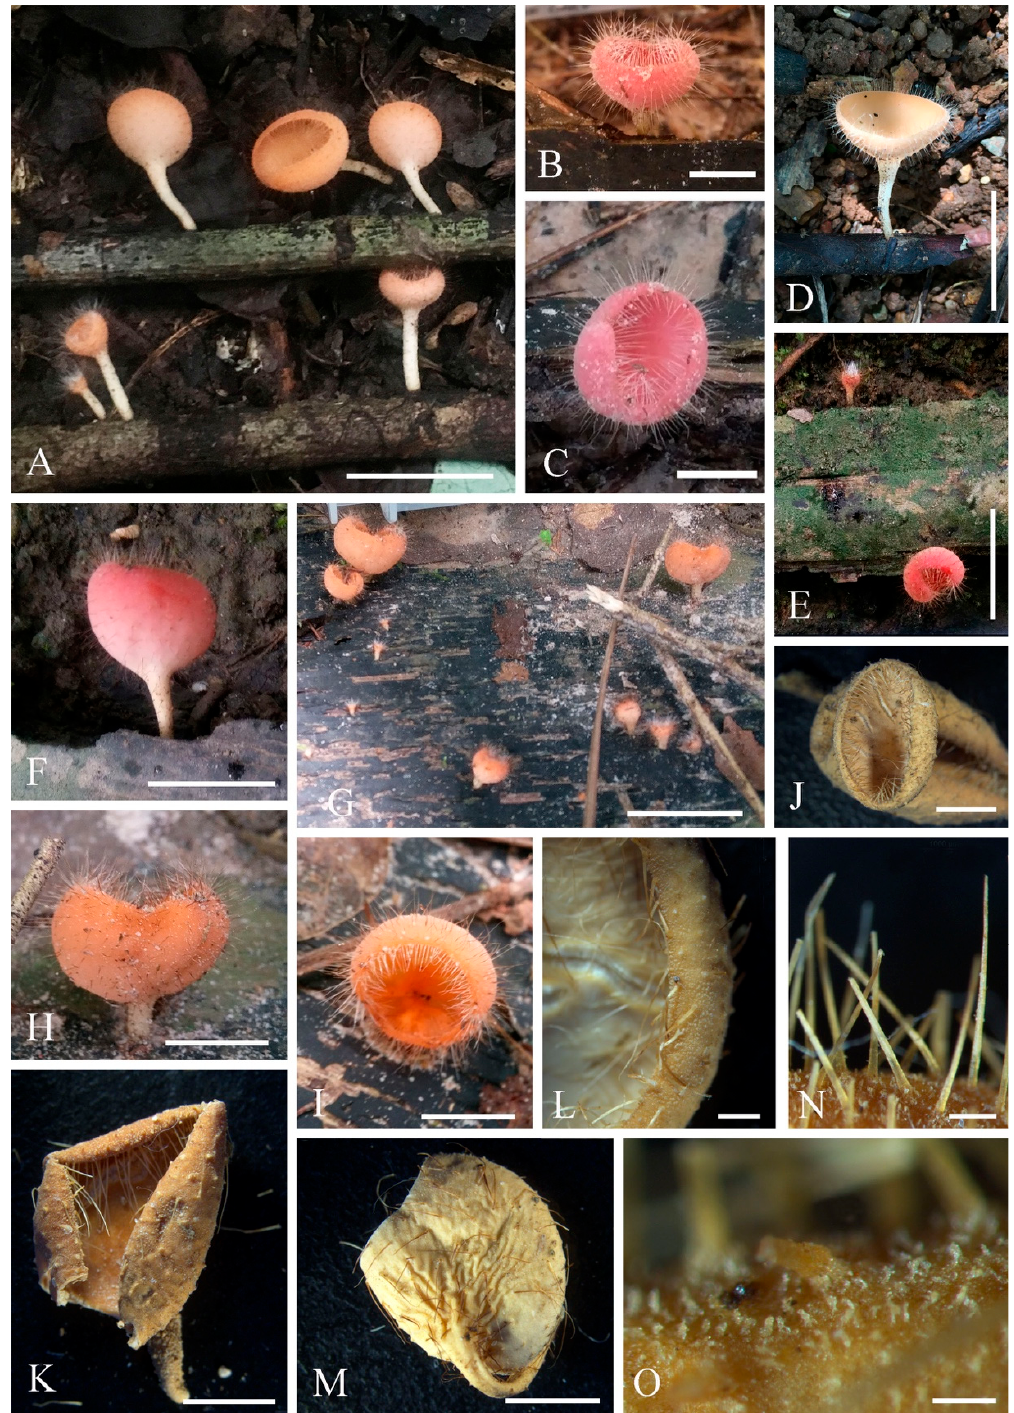
Figure 11. Cookeina tricholoma . ( A – I ) Fresh apothecia [( A ) HKAS 121191. ( B , C ) MFLU 21 ‐ 0165. ( D ) MFLU 21 ‐ 0163. ( E , F ) MFLU 21 ‐ 0168. ( G – H ) MFLU 21 ‐ 0167. ( I ) MFLU 21 ‐ 0166.] ( J , K , M ) Dry apothecia [( J ) MFLU 21 ‐ 0168. ( K ) MFLU 21 ‐ 0165. M HKAS 121191.] ( L ) Margin (HKAS 121191). ( N ) Compound hairs (MFLU 21 ‐ 0164). ( O ) Receptacle surface of an apothecium (MFLU 21 ‐ 0163). Scale bars ( A , E , G ) = 3 cm; ( B , C , H , I ) = 1 cm; ( D , F ) = 2 cm; ( J , K , M ) = 5000 μ m; ( L ) = 1000 μ m; ( N ) = 500 μ m; ( O ) = 200 μ m.